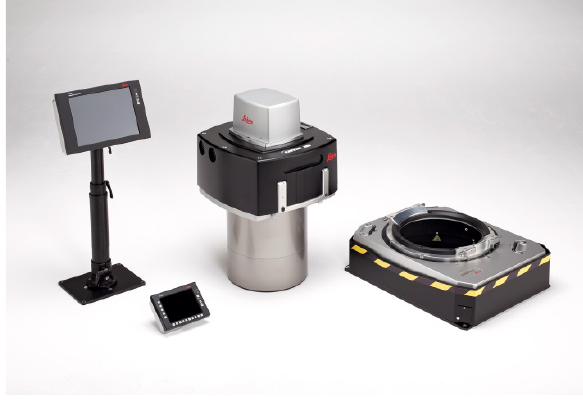
Figure 1 DMC III camera system